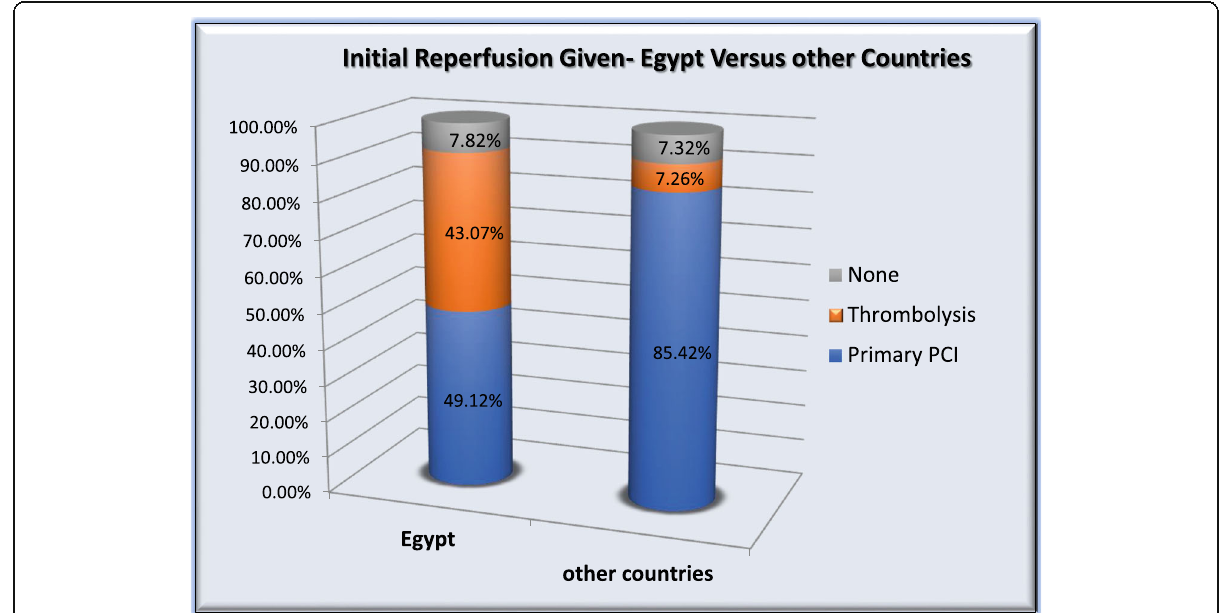
Fig. 2 Initial reperfusion given in Egypt vs. other